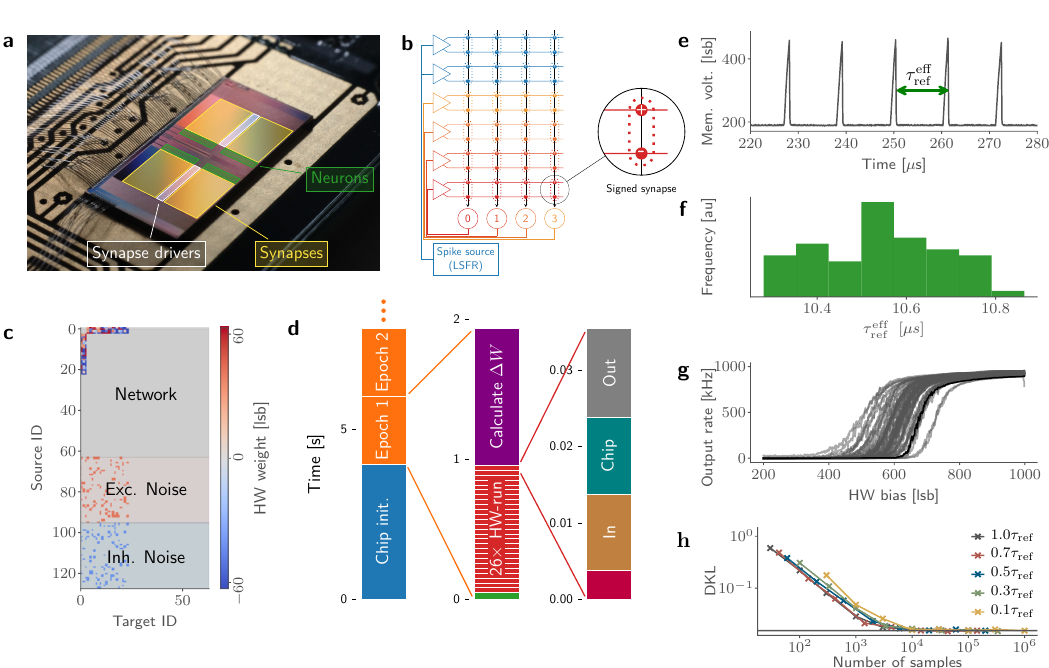
Figure 5: Details of the BrainScaleS-2 neuromorphic chip. a , Photograph of the BrainScaleS-2 chip with circuits of 4 × 128 AdEx-LIF neurons (green), 2 × 2 × 128 synapse drivers (white) and 4 synapse arrays with 256 × 128 synapses (yellow). b , Routing schematic used to implement the sampling spiking network. Each synapse driver projects to two synapse rows in order to allow signed synapses. c , Utilized logical connectivity matrix projecting onto the 64 neurons used. Network (neuron- to-neuron) connections are truncated at index 24 (4 visible and 20 hidden) and intra- layer connections are not used. Each neuron receives noise input from 5 excitatory (64-95) and 5 inhibitory (96-127) sources, generated by one on-chip LSFR each. Each connection selects the appropriate synapse row depending on its sign (cf. b ) d , Time usage across a training experiment. The initial configuration (blue) of the chip is comparable to a single epoch (orange). Each epoch consists of a parameter update (green), 26 sampling runs (red) and the update calculation (purple). Each hardware run consists of the construction of the playback program (ruby), the initial buffering on the FPGA (brown), the actual chip runtime (turquoise) and the readout to the host (grey). e , Membrane trace of an exemplary neuron at the high-bias end. τ eff is ref . Variations are due to the ana- the inter spike interval. f , Histogram of measured τ eff ref log nature of the system. g , Activation functions as a function of the leak potential under noise input of the 64 neurons used. τ eff is estimated by the output frequency ref at the high-bias end. h , Sampling performance as a number of samples, rather than execution time for different sampling time deltas dt . More than two samples per ≈ 10 µ s increase the Kullback-Leibler divergence as the samples refractory time τ eff ref are not